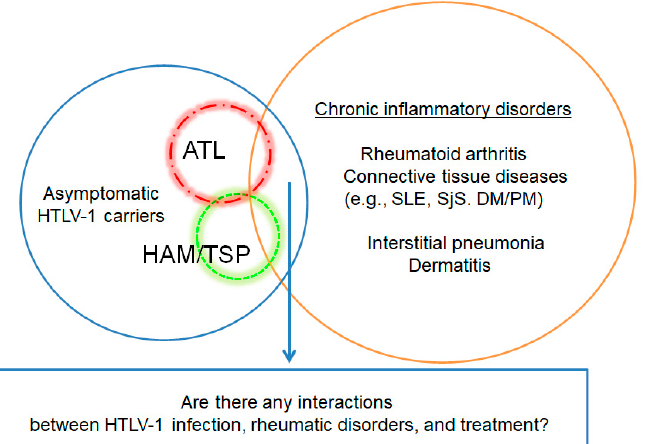
Figure 3. Human T-cell leukemia virus type 1 (HTLV-1) infection in chronic inflammatory disor-